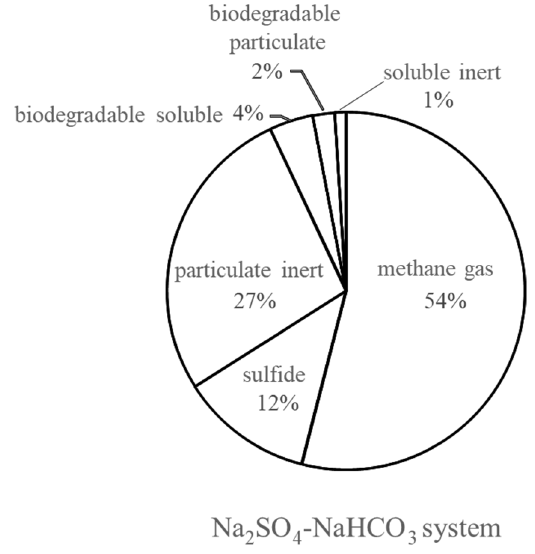
Figure 7. Conversion rate from the Na 2 SO 4 –NaHCO 3 system in the steady state.